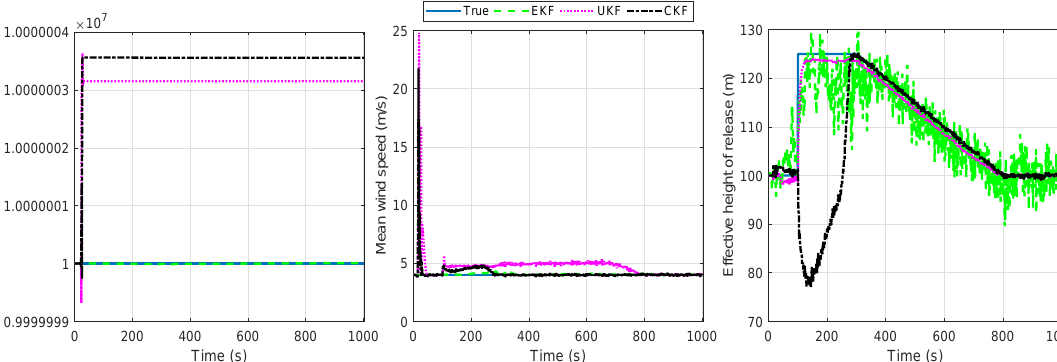
Figure 7. True and estimated release rate, wind speed, and height of release for variation in release